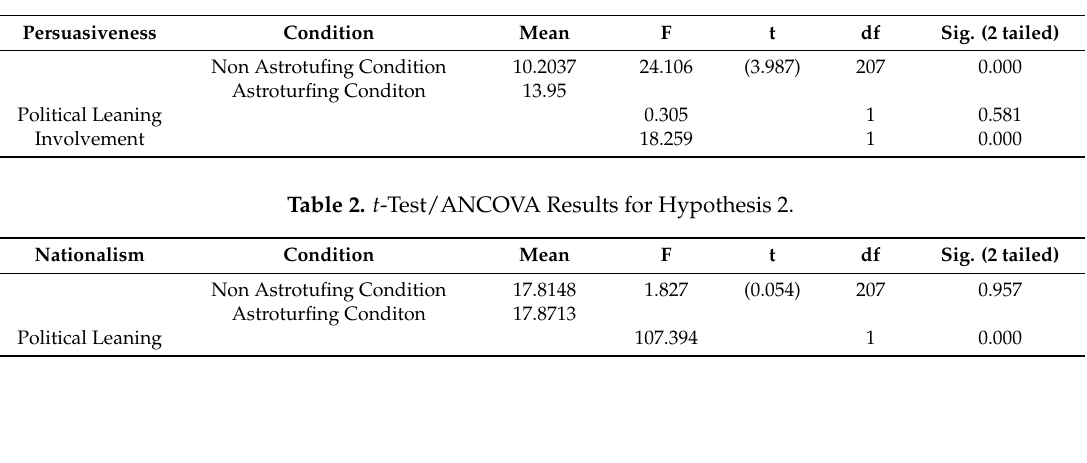
Table 1. t -Test/ANCOVA Results for Hypothesis 1/1a.